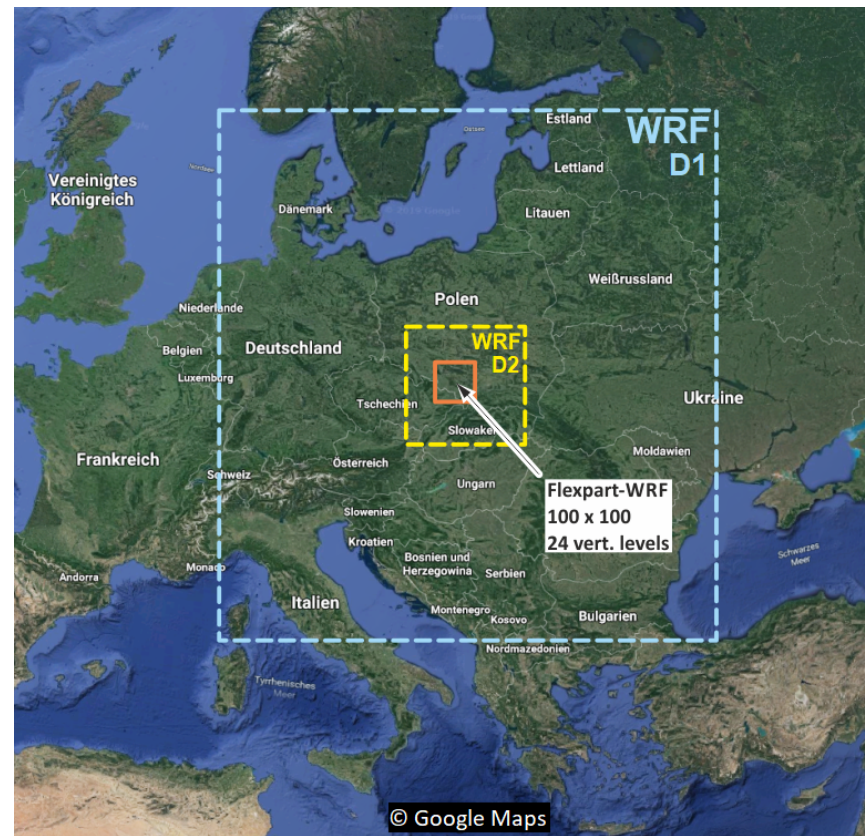
Figure 4. The FLEXPART-WRF domain resides in the nested WRF domain D2 providing the meteorological driver data. Generous spacing towards the driver domain has been included to avoid spurious boundary